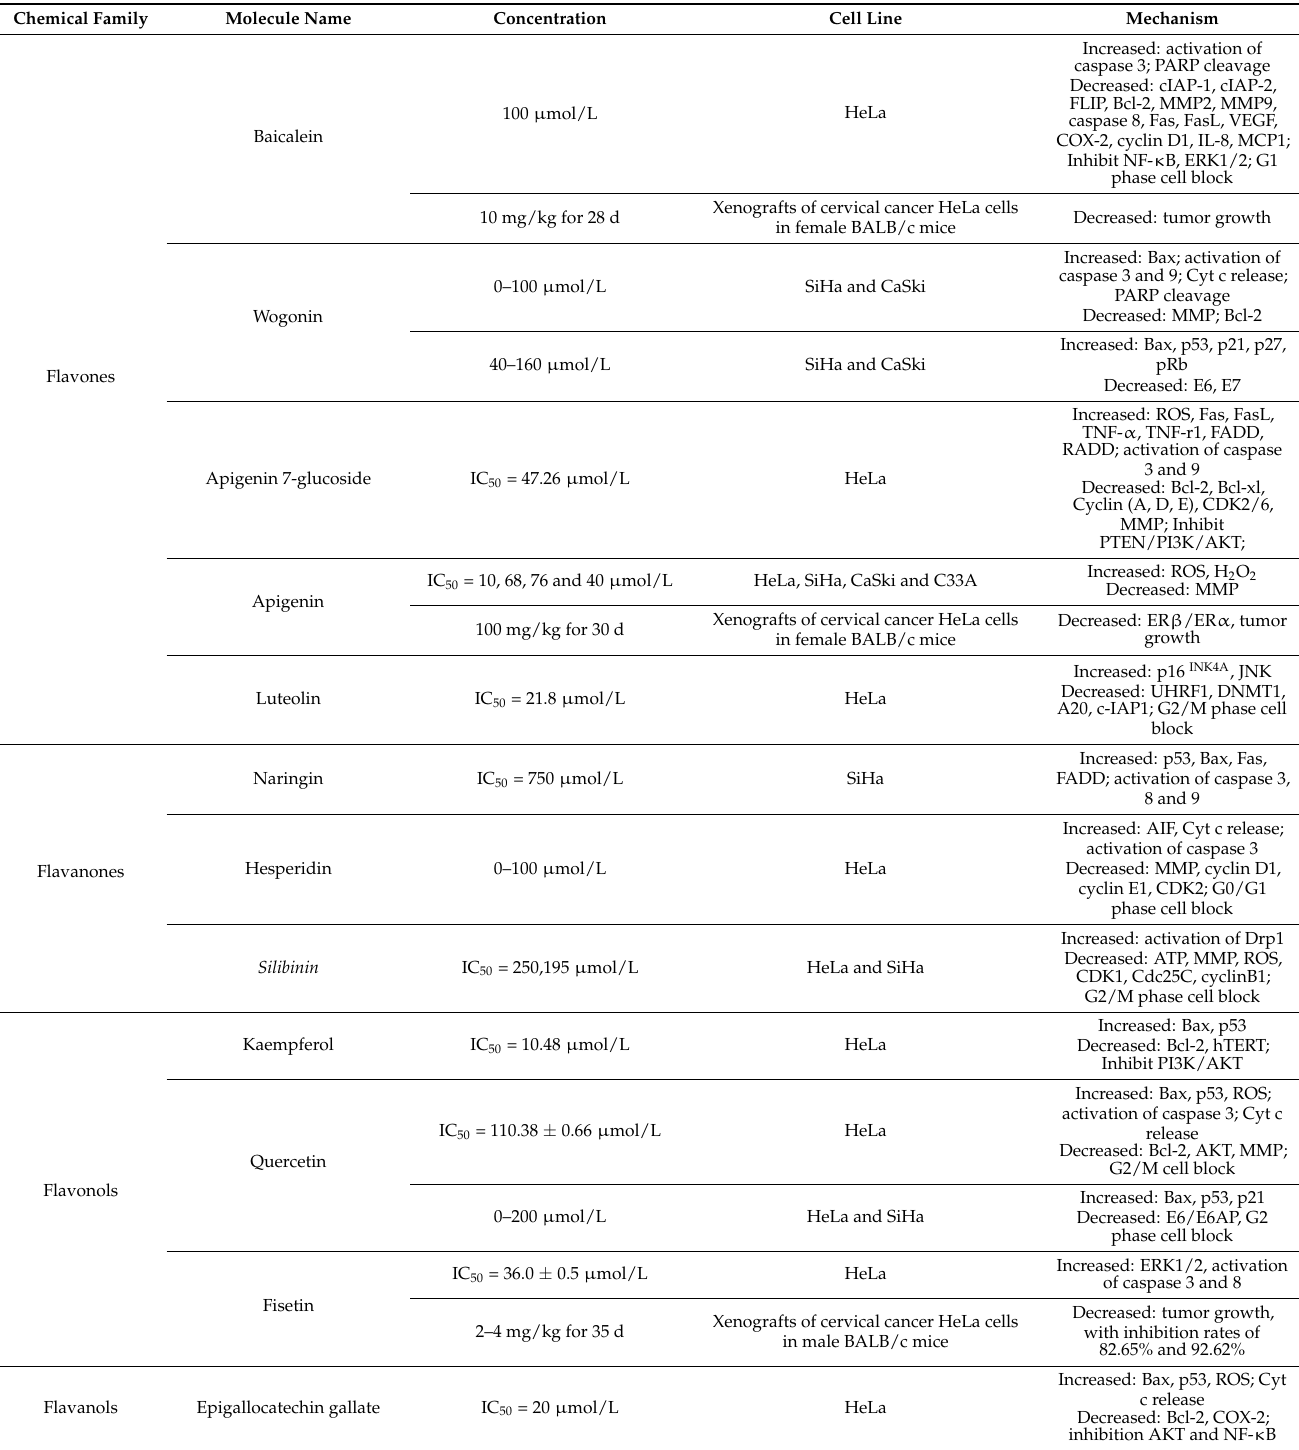
Table 1. Effect and mechanism of flavonoids on cervical